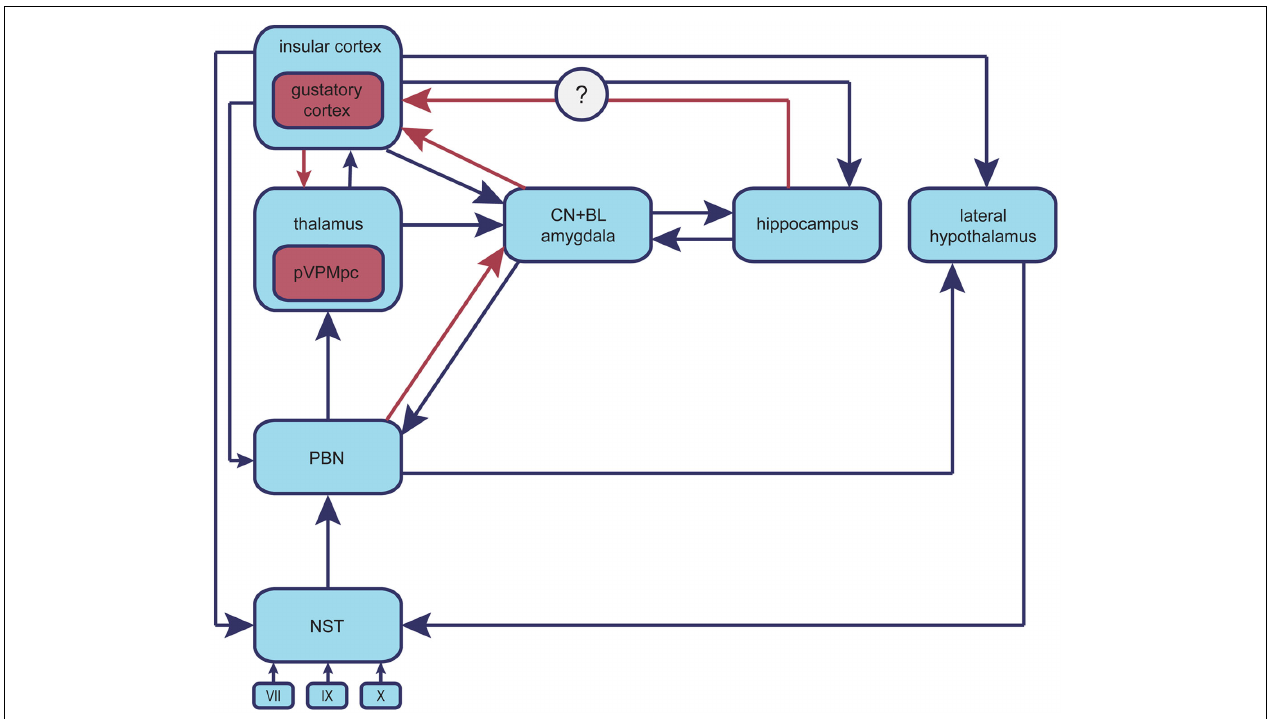
medullary and reticular-formation neurons, which innervate the cranial motor nuclei.The lemniscal system consists of projections of the gustatory portion of the NST to the secondary nucleus situated in the dorsal pons (PBN); this, in turn, sends axons to the pVPMpc, which ultimately relays gustatory information to the anterior part of the insular cortex (GC).The visceral–limbic system refers to a collateral network of connections to the hypothalamus and limbic areas in the forebrain, which comprises the central gustatory pathway. The PBN is connected to the amygdala, the hypothalamus, and the bed-nucleus of the stria terminalis. All limbic gustatory targets are interconnected with each other as well as with the PBN and the